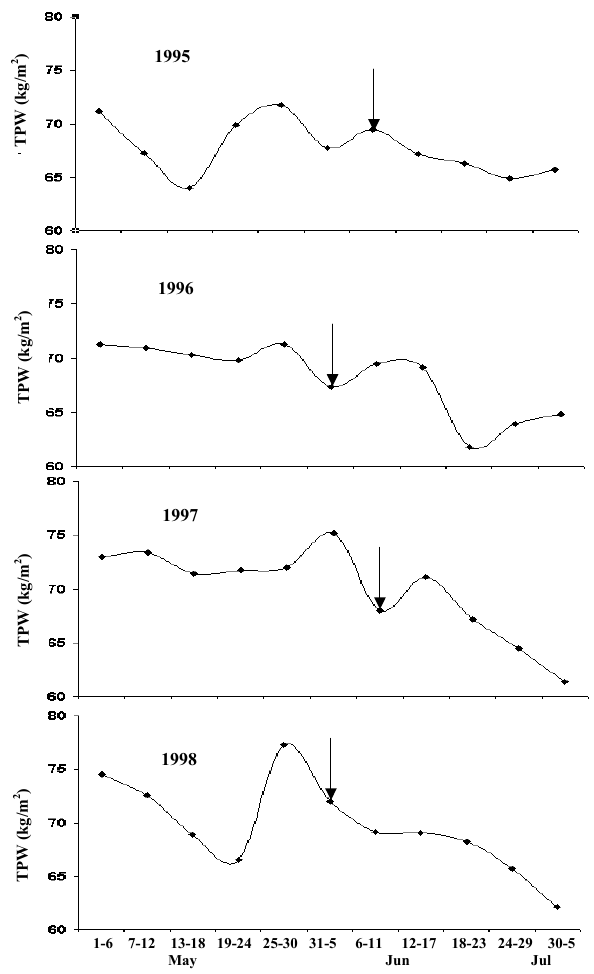
Fig. 4. Weekly Variations of TPW in the latitude zone 10 - 15 0 N for 1995 – 1998 (arrows indicate onset week of monsoon) Fig. 4. Weekly variations of TPW in the latitude zone 10–15 ◦ N for